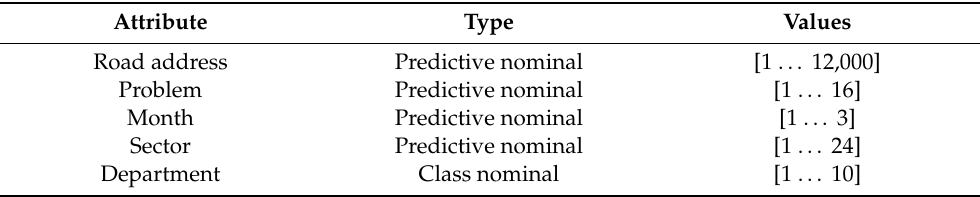
Table 6. Cholargos municipality section per season dataset